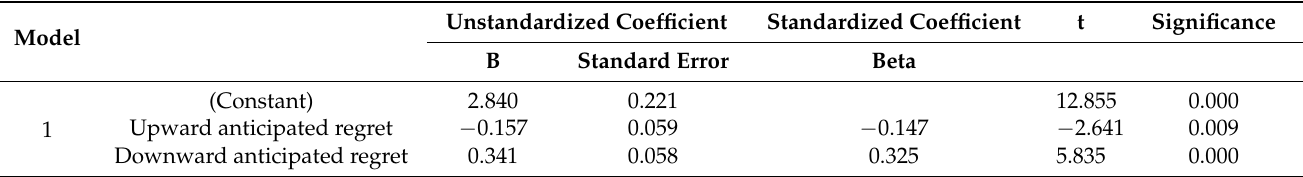
Table 13. Regression coefficient a